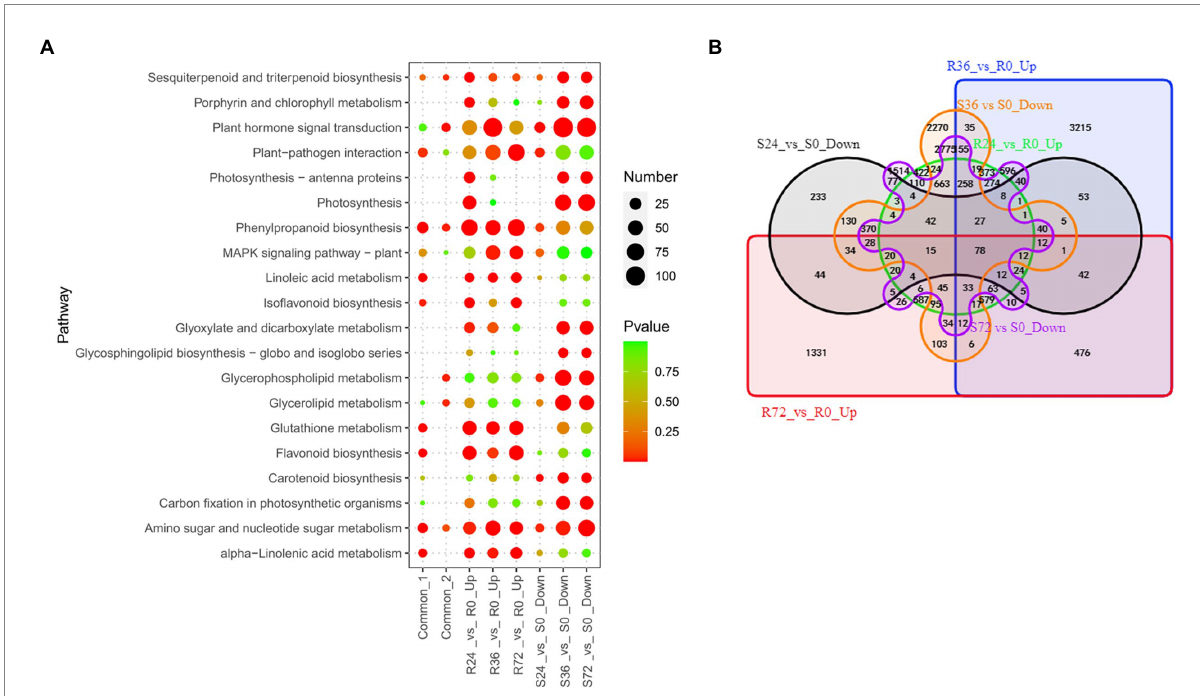
FIGURE 3 Identification of resistance-response DEGs in R24 vs. R0, R36 vs. R0, R72 vs. R0, S24 vs. S0, S36 vs. S0, and S72 vs. S0. (A) KEGG enrichment analysis of common, up-regulated, and down-regulated DEGs in each treatment comparison. Common-1 indicates the common up-regulated DEGs in R24 vs. R0, R36 vs. R0, and R72 vs. R0. Common-2 is the common down-regulated DEGs in S24 vs. S0, S36 vs. S0, and S72 vs. S0. (B) A big Venn diagram of DEGs for up-regulated DEGs in Rs vs. R0 and down-regulated DEGs in Ss vs.